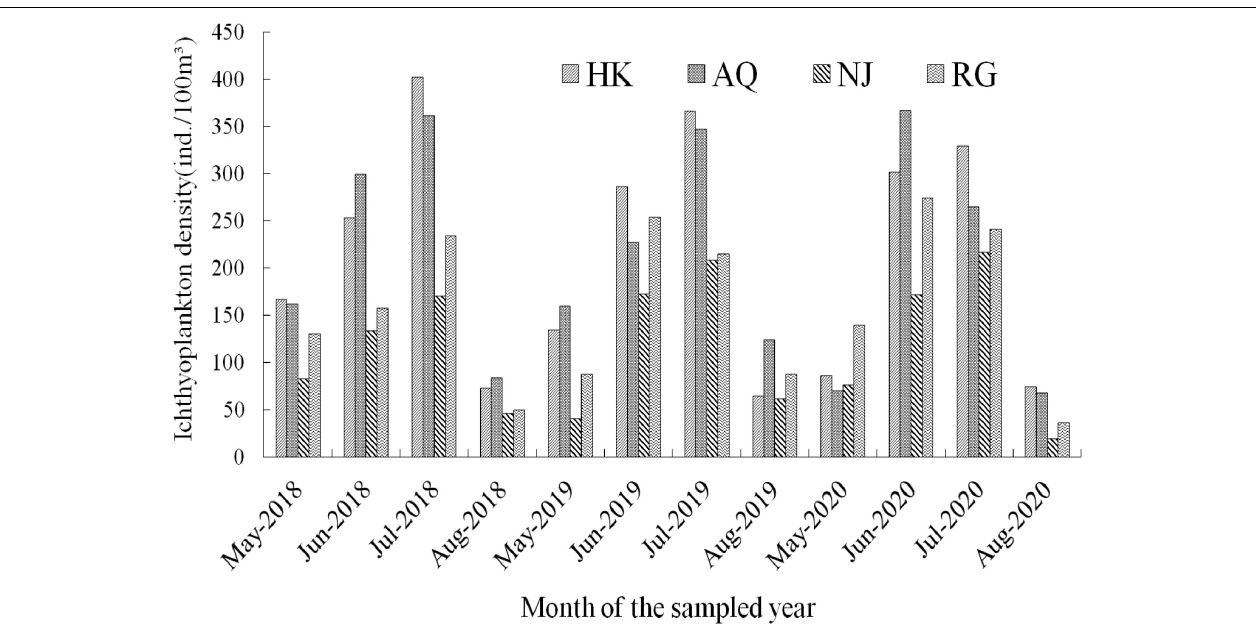
FIGURE 3 | Monthly density of ichthyoplankton in different river